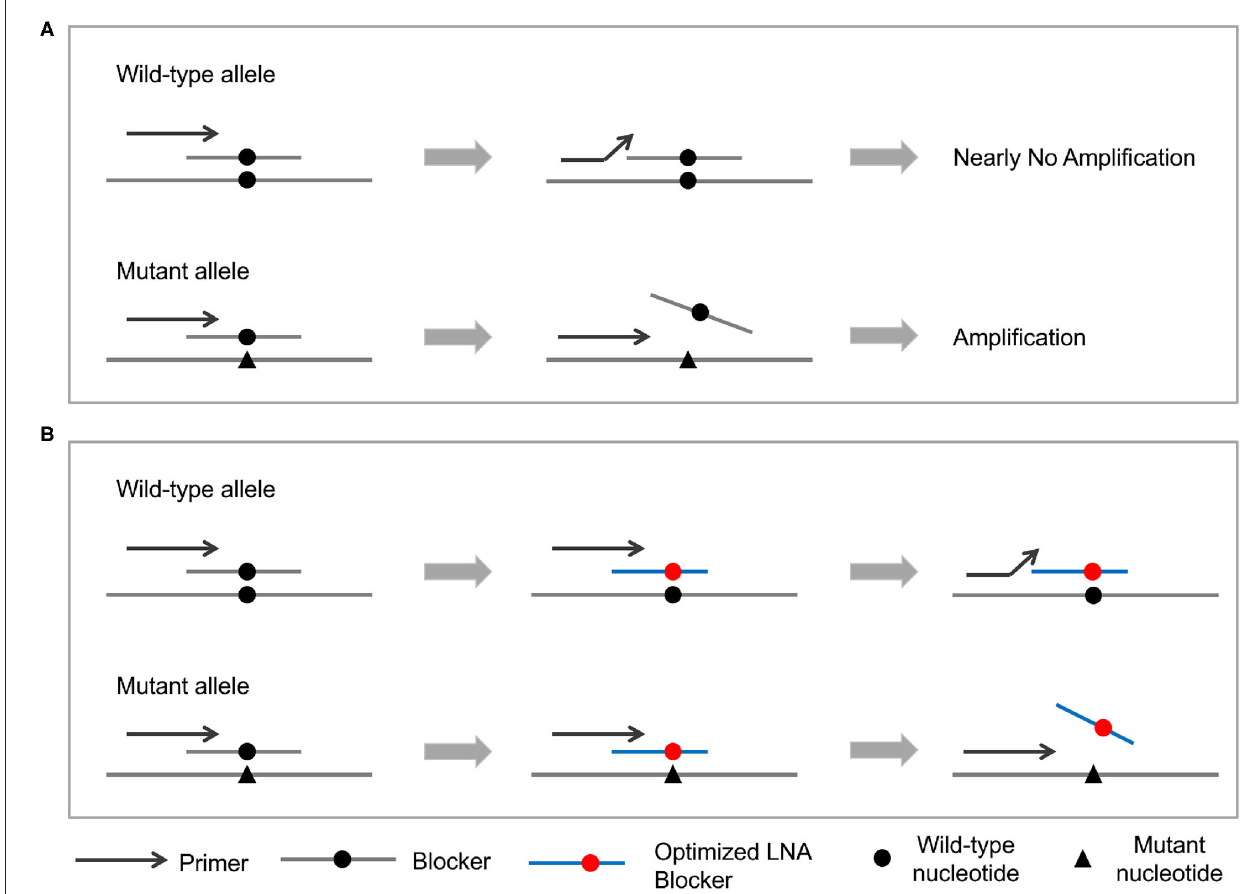
FIGURE 1 | Principle of the PEAC methodology. (A) The general PEAC workflow for NSCLC driver mutations. Forward primers and blocker probes are competitively binding to the DNA template. For wild-type template, blocker probes prevent primers binding and cause no PCR amplification. On the other hand, blocker probes could not bind to the mutant template and let the PCR amplification goes unhindered. (B) Adjustment of PEAC method for specific mutations, such as EGFR T790M and L861Q. These two blocker probes are modified with locked-nucleic acid (LNA) and with optimized length eliminate the false